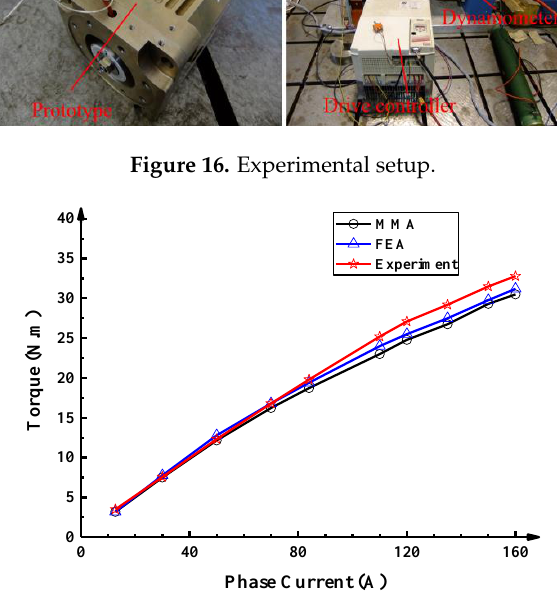
Figure 17. The torque comparisons of the experiment measurement and simulations at different current.